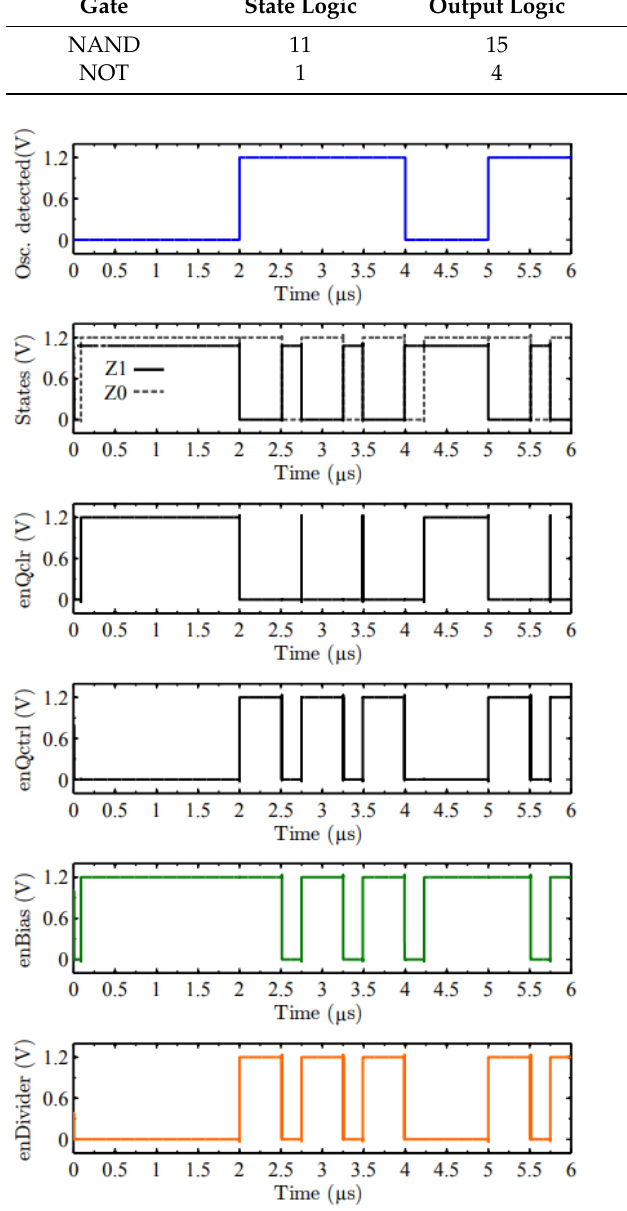
Figure 15. Simulated waveforms of the state machine with quench timer connected for a random input bit pattern (top, blue) at 1 Mbps.